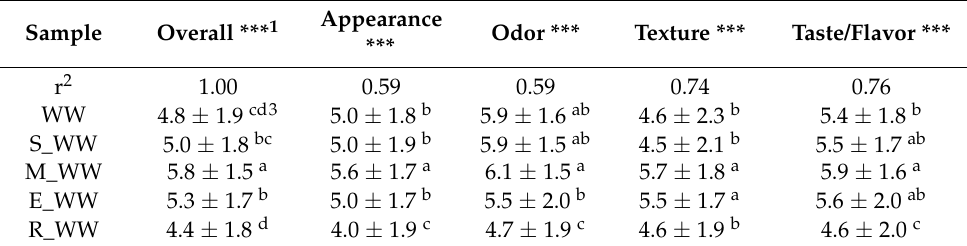
Table 2. Mean liking scores of various processed whole wheat